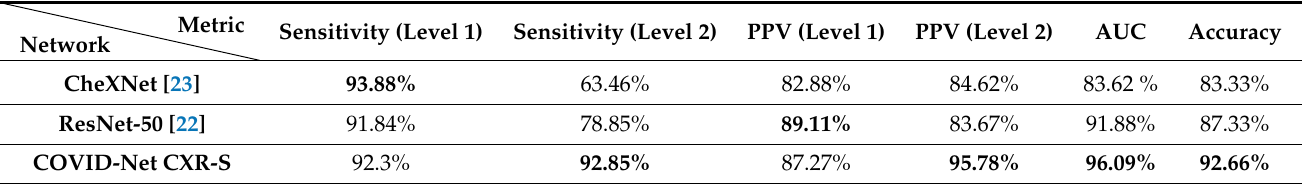
Table 3. Sensitivity, positive predictive value (PPV), and accuracy of the proposed COVID-Net CXR-S,